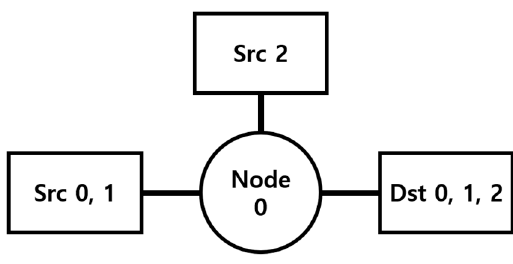
Figure 12. Training results according to SARL’s RL algorithm and deep learning network structure when random flows are generated in topology 2.